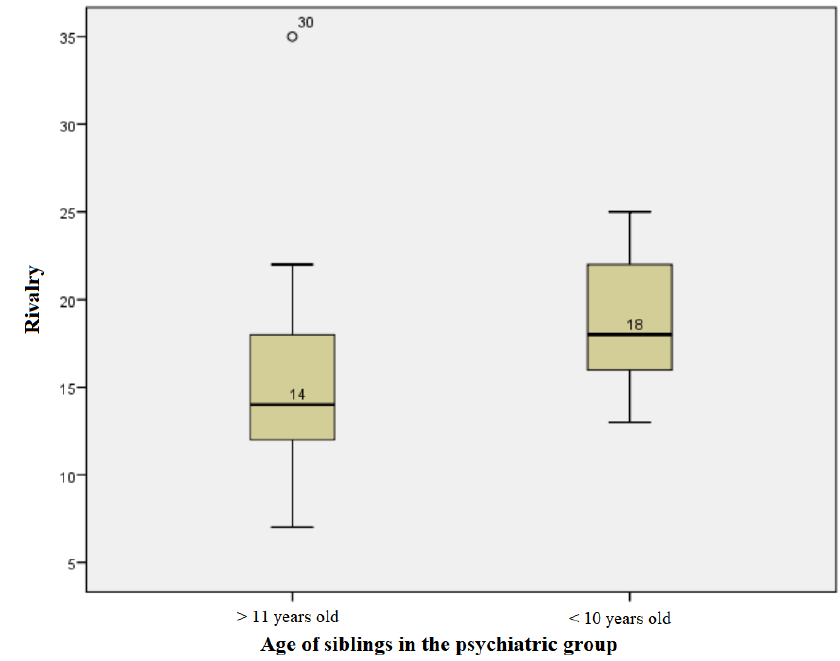
Figure 5. Age influence on rivalry scores in the psychiatric group.